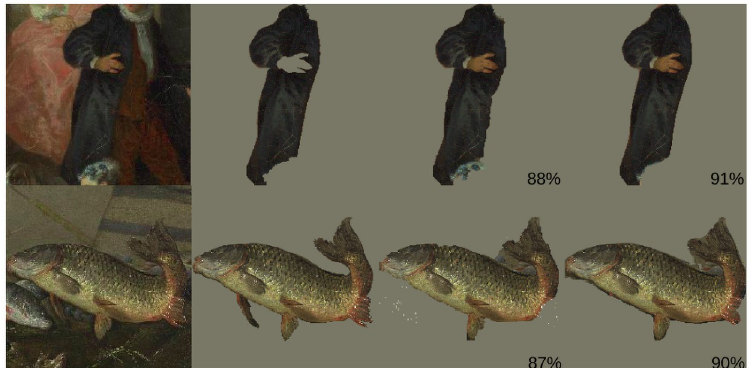
Fig 12. Segmentation visualizations. Left to right: Original Image, Ground Truth Segment, Grabcut Extr Segment, DEXTR COCO Segment. Both Grabcut and DEXTR use extreme points as input. For evaluation, the extreme points are generated synthetically from the ground truth segments. The IOU for each segmentation is shown in the bottom right corner. Top image: Dance before a Fountain , by Nicolas Lancret , 1724, Digital image courtesy of the Getty’s Open Content Program. Bottom image: Still life with fish , by Pieter van Noort , 1660, Het Rijksmusuem. Images reproduced under a CC0 license.